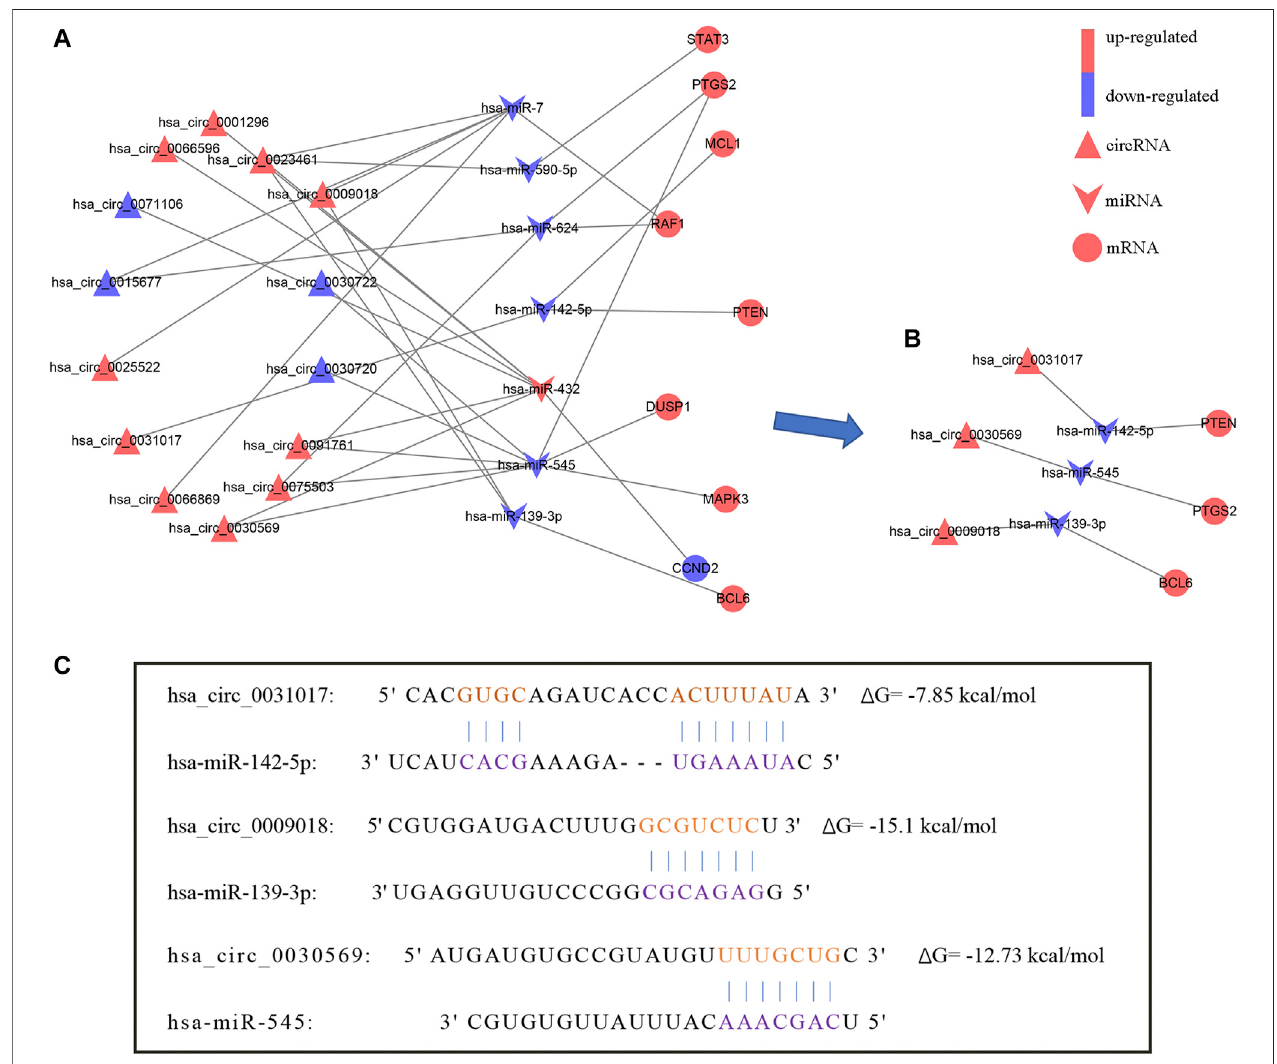
FIGURE 6 | The circRNA-miRNA-hub gene network. (A) CircRNA-miRNA-hub gene network. (B) The hsa_circ_0031017/hsa-miR-142-5p/PTEN axis, hsa_circ_0030569/hsa-miR-545/PTGS2 axis and hsa_circ_0009018/hsa-miR-139-3p/BCL6 axis were con fi rmed by qRT-PCR. (C) The binding sites of hsa_circ_0031017, hsa_circ_0030569 and hsa_circ_0009018 with